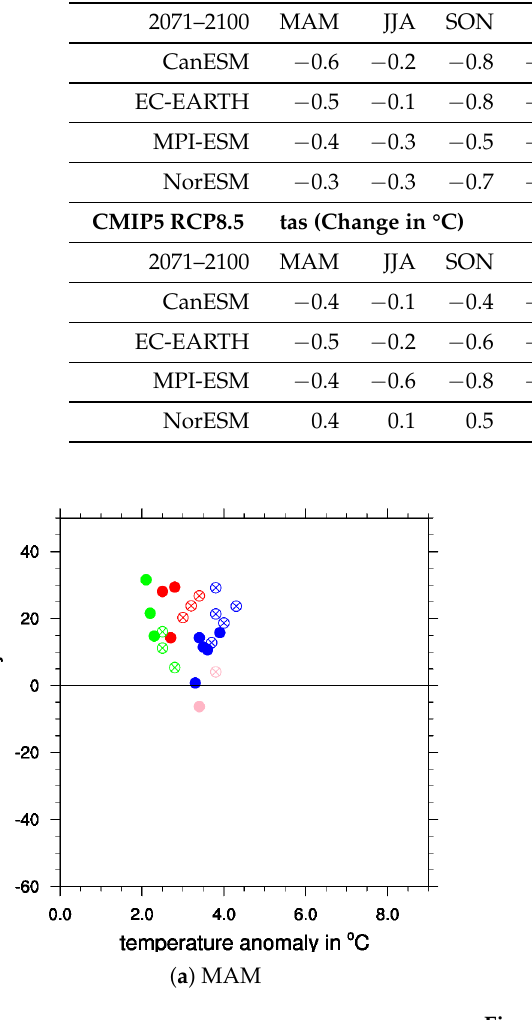
Table 3. Mean (annual and seasonal) difference of the EPISODES downscaling results and the direct GCM output (EPISODES trend minus GCM trend) for temperature (tas) and precipitation (pr), as observed in Figures 4 and 5. Seasons are defined as follows: spring (MAM), summer (JJA), autumn (SON), winter (DJF). CMIP6